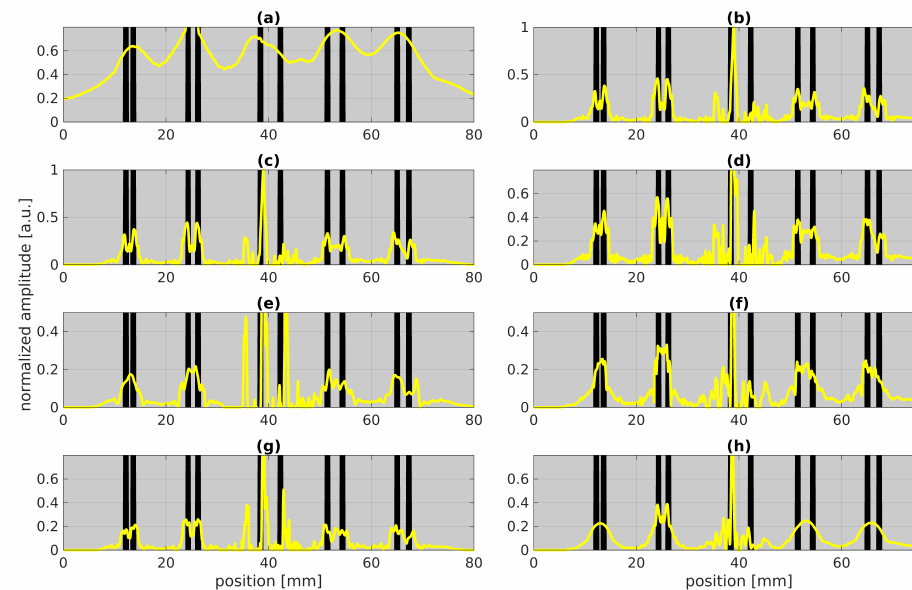
Figure 6. Parameter studies for tied LBISTA applied to experimental test data shown in Figure 3. The blackened areas represent the blackened stripes for better orientation. The blue curves stand for the result after applying the tied LBISTA to the experimental test data. All images are based on the parameter choice shown in Table 1. The following parameters have been changed, respectively: ( a ) N B = 100, ( b ) N B = 200, ( c ) defect width = 0.5mm, ( d ) defect width = 2mm, ( e ) defect sparsity PNZ = 0.005, ( f ) defect sparsity PNZ = 0.03, ( g ) only one refinement f m = { 0.5 } , ( h ) only three layers K = 3 and one refinement f m = { 0.01 } .